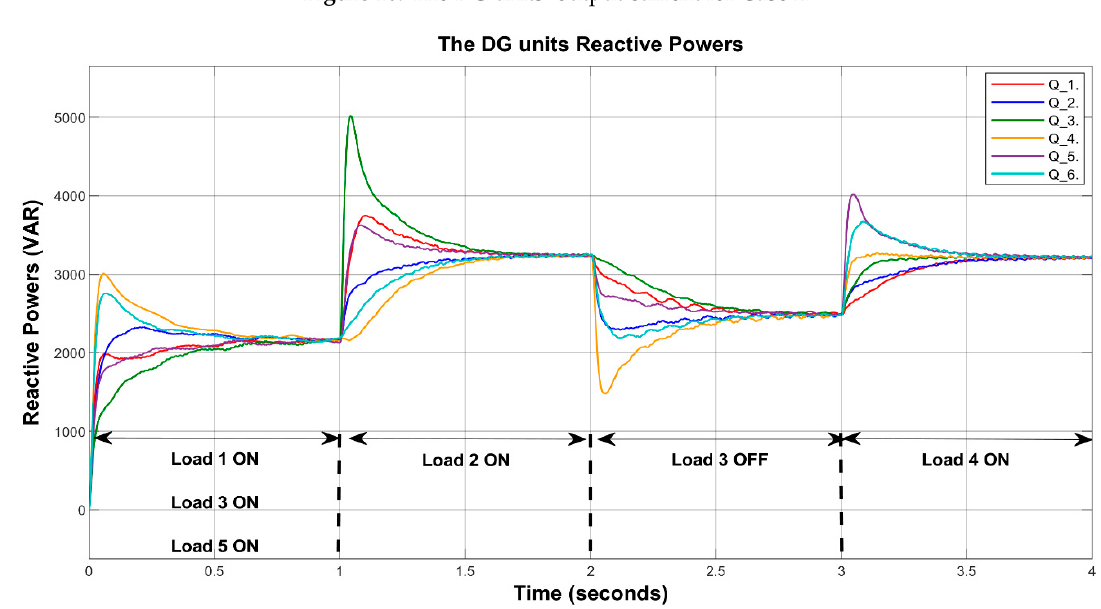
Energies 2020 , 13 , 2026 Figure 16. The DG units’ output current for Case 2. Figure 16. The DG units’ output current for Case 2.